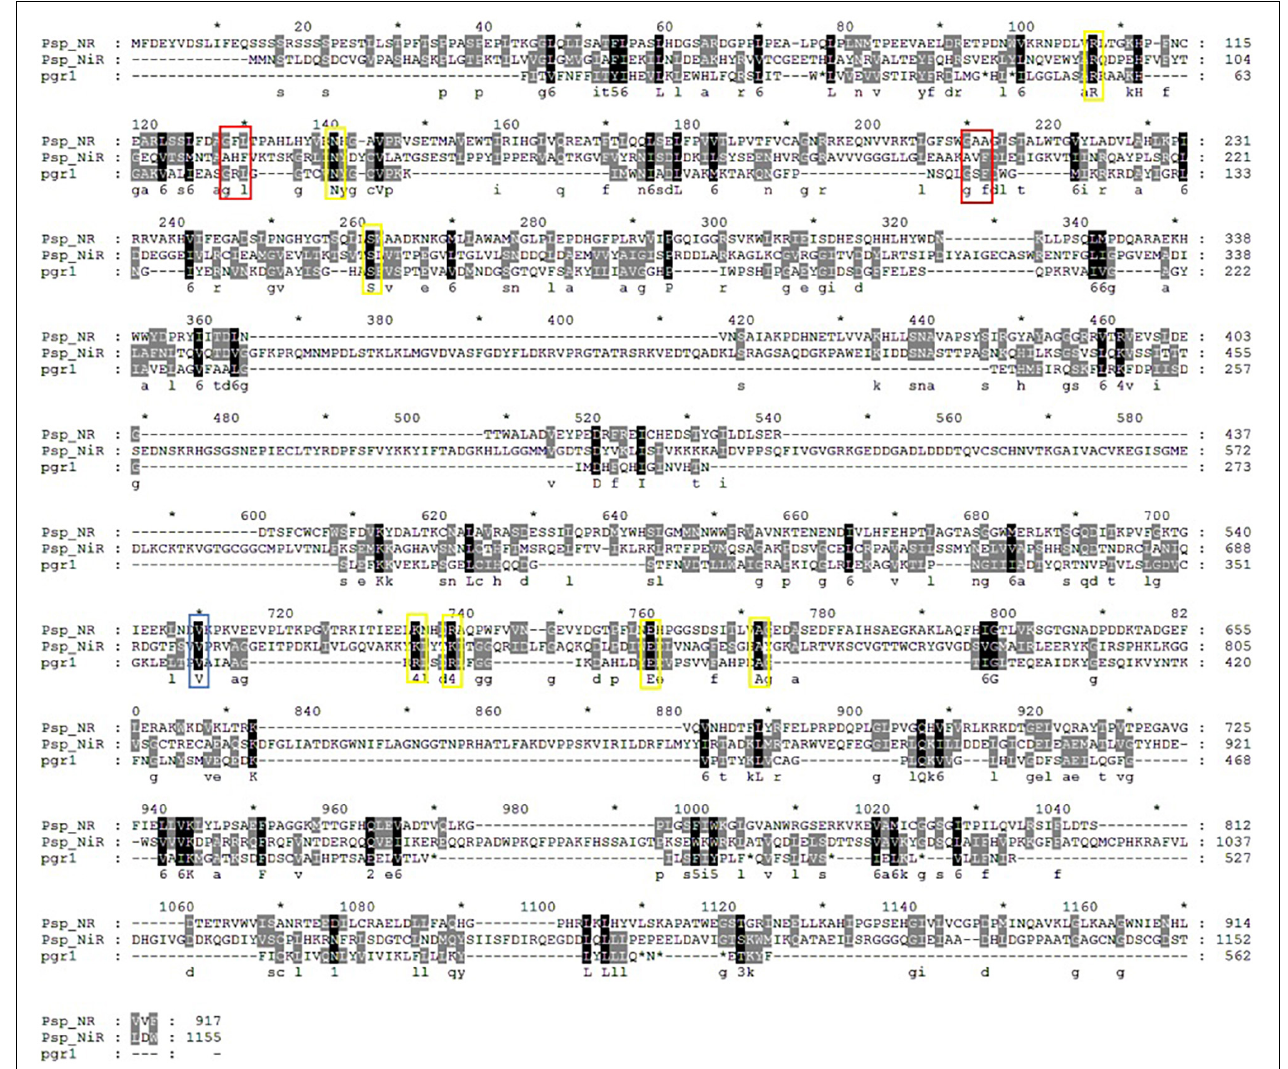
FIGURE 6 | Multiple alignment of Pisolithus sp.1 NR, Pisolithus sp.1 NiR and the pgr1. The FMN-binding and NADPH-binding sites are labeled with yellow and blue rectangles, respectively, and the sites marked with red rectangles are both FMN- and NADPH-binding